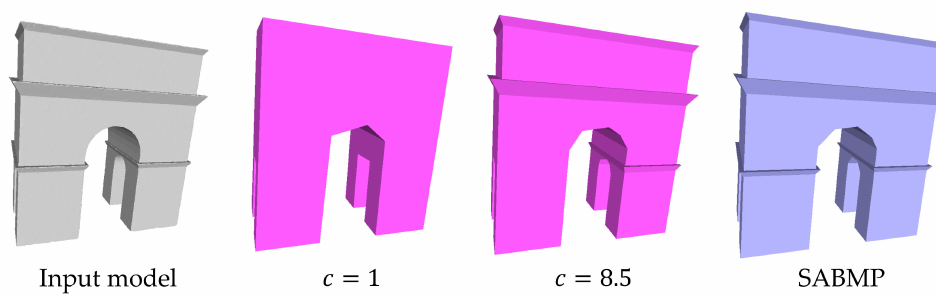
Figure 17. Simplification effect of the high-quality mesh model.